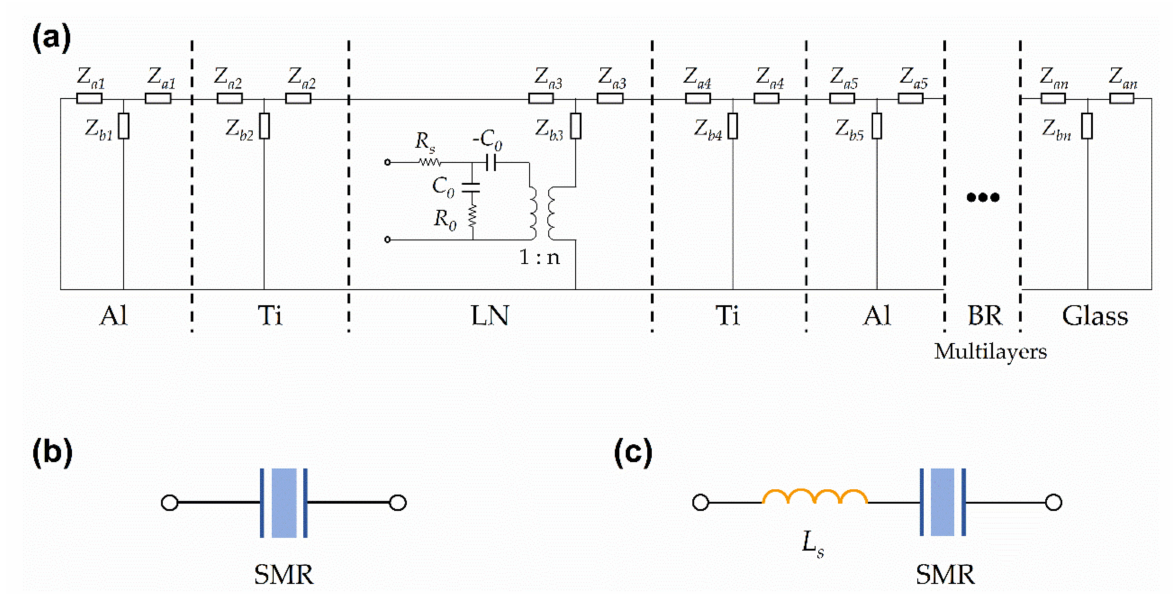
Figure 8. ( a ) Sub circuit of SMR by the Mason model; ( b ) Encapsulated module of SMR with the sub circuit of ( a ), in which the resonant area is an independent variable; ( c ) Equivalent circuit of SMR connected in series with inductor L s by the encapsulated module of the Mason